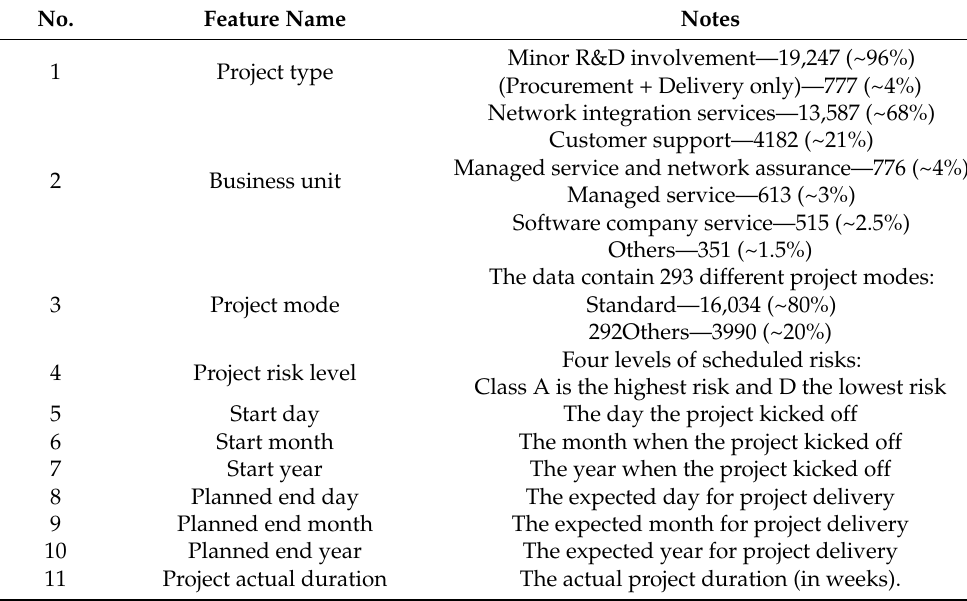
Table 1. Project Features of Organization 1.